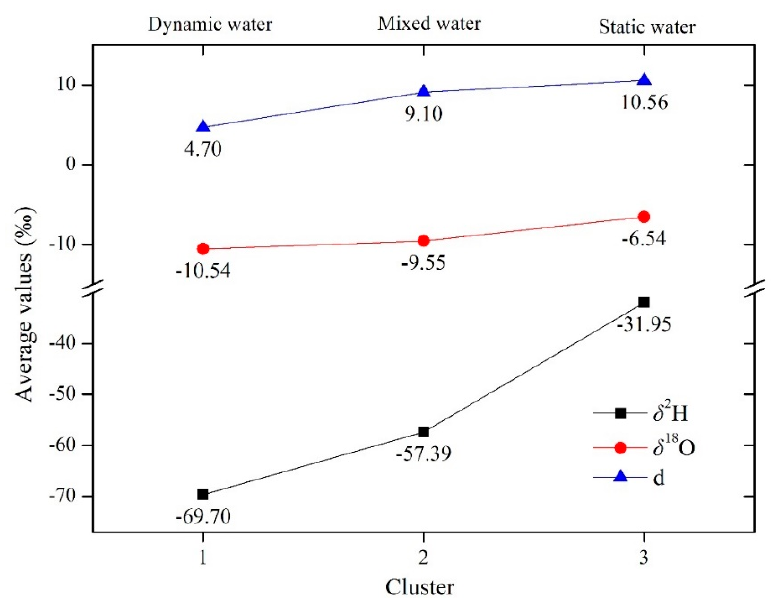
Figure 9. Comparison of the average isotope values of the three clusters.